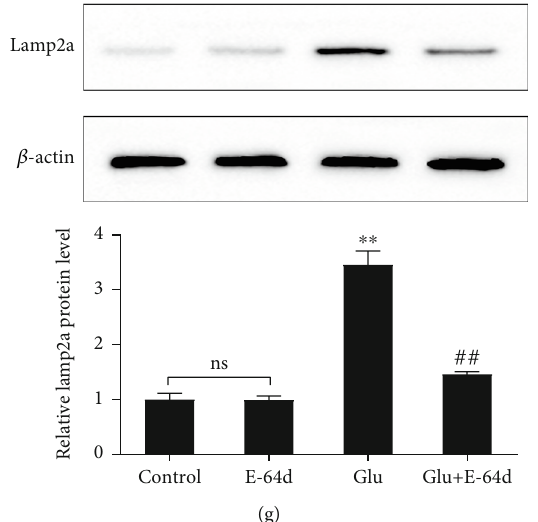
Figure 5: HT22 cells were treated with glutamate and E-64d for 24h. The protein expression of Beclin-1 (a), Caspase-3 (b), LC3-II/I (c), Cytc (d), Drp1 (e), Hsc70 (f), and Lamp2a (g) was measured by Western blotting. Three independent experiments were performed, and the data are expressed as the mean ± SD . ∗∗ P < 0 : 01 vs. the Control group. ## P < 0 : 01 vs. the Glutamate group. n.s.: not signi fi